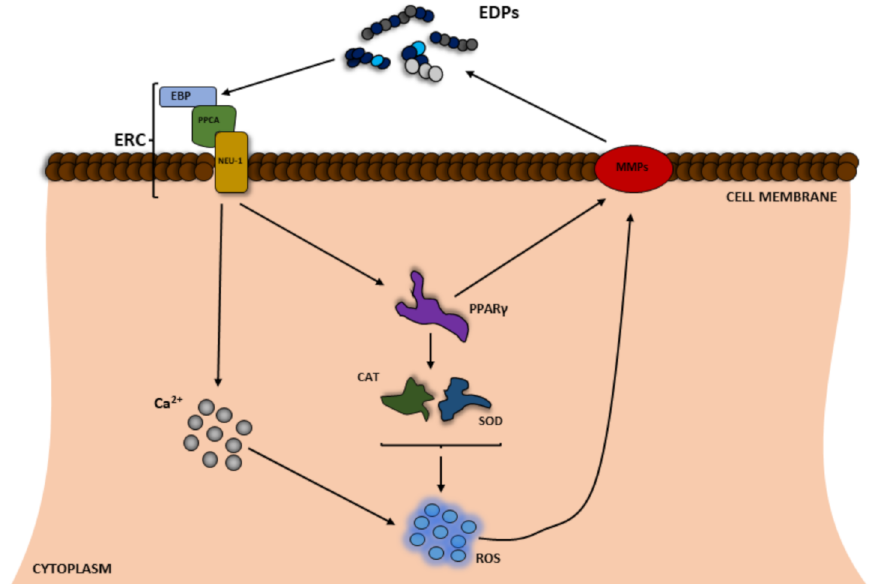
Figure 2. Scheme of the positive feedback of reactive oxygen species (ROS) and elastin degradation yielding elastin-derived peptides (EDPs), which induce ROS production. EBP—elastin-binding protein; Neu1—neuraminidase; PPAR γ —peroxisome proliferator-activated receptor gamma; PPCA— protective protein/cathepsin A; ERC—elastin receptor complex; CAT—catalase; SOD—superoxide